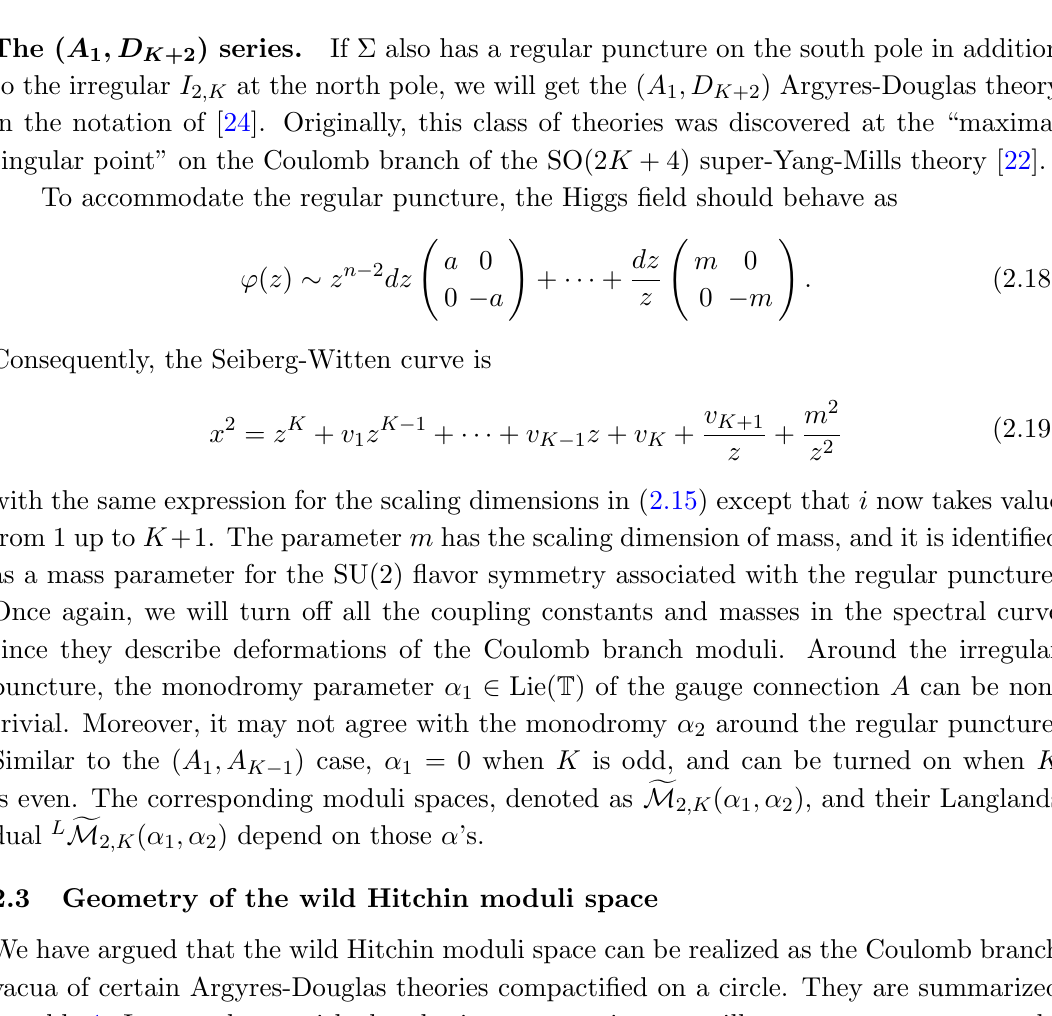
Table 1. Summary of A 1 Argyres-Douglas theories, the order of singularities of the Higgs (cid:12)elds, the corresponding wild Hitchin moduli spaces and their